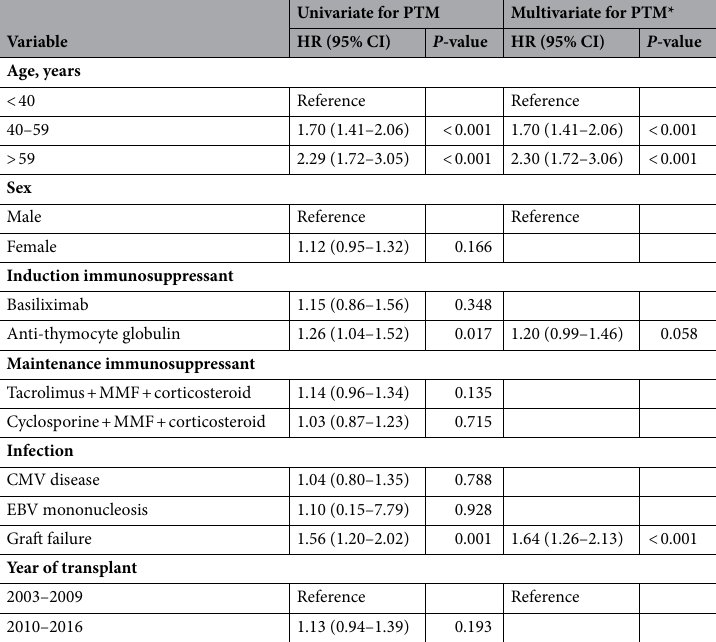
Table 5. Univariate and multivariate analysis for post-transplant malignancies. CMV cytomegalovirus, EBV Epstein–Barr virus, MMF mycophenolate mofetil, HR hazard ratio, PTM post-transplant malignancy. *Variables less than 0.05 of P -values in univariate analysis were included in the multivariate